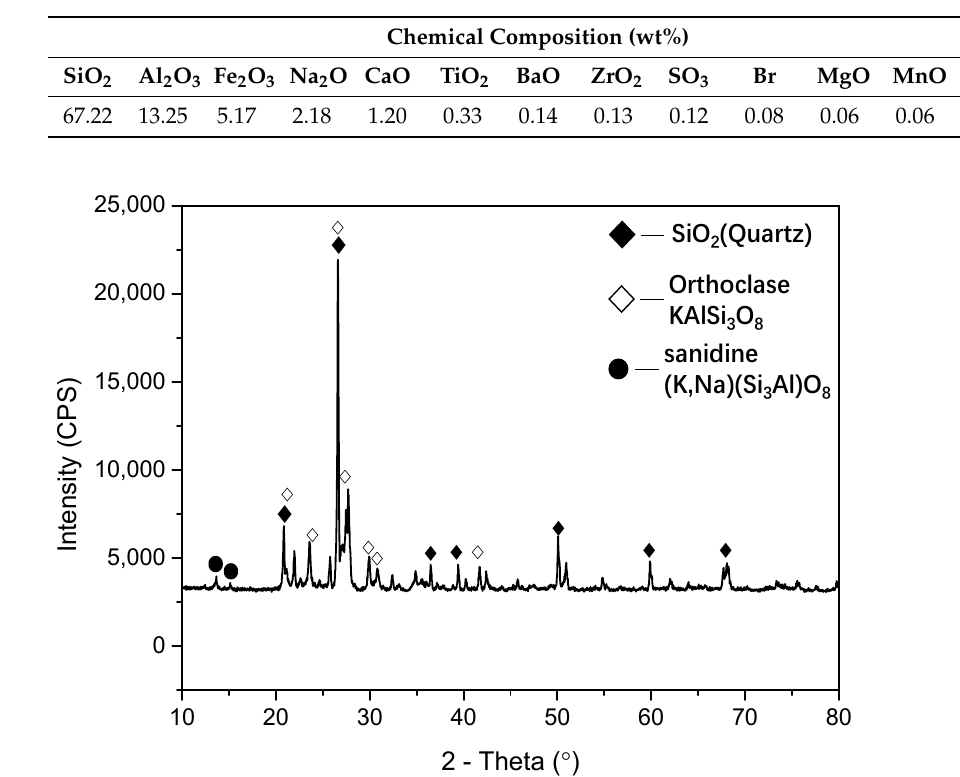
Figure 2. X-ray diffraction (XRD) patterns of stone powder.